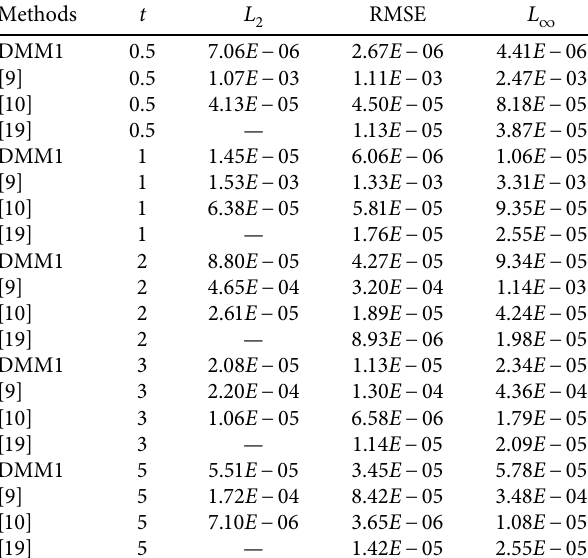
Table 3: Numerical results for Example